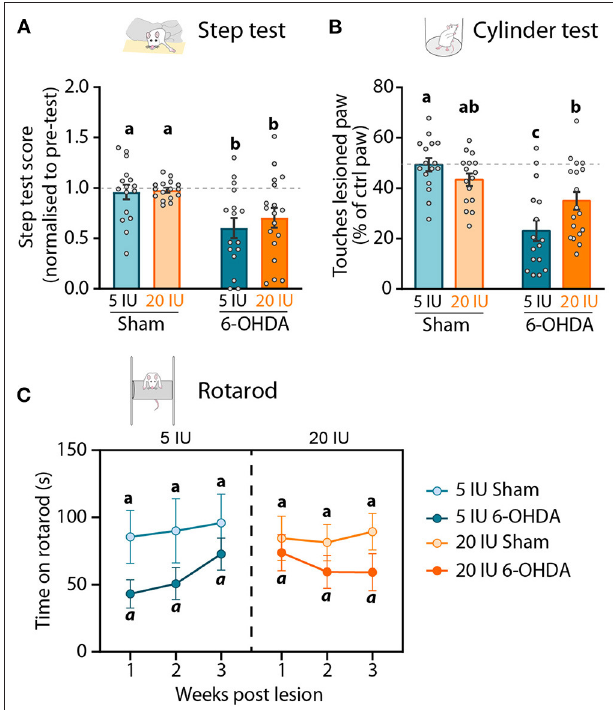
FIGURE 3 | Impact of 6-OHDA injection and dietary vitamin A on motor behavior. (A) Step test: Step test score 3 weeks after the lesion represents the number of steps made by the lesioned paw as the percent (%) of the total number of steps, normalized to the step test performed before the lesion. (B) Cylinder test: number of touches made by the lesioned paw expressed as % of total touches made by the control paw the cylinder test 3 weeks after the lesion. (C) Rotarod test: latency to fall (s) of rats from the apparatus 1, 2 and 3 weeks after the lesion. Results are expressed as means ± SEM, with individual data points for histograms. a–c: values significantly different ( p < 0.005, a : p = 0.059). Details of the statistical analysis are summarized in Table 3